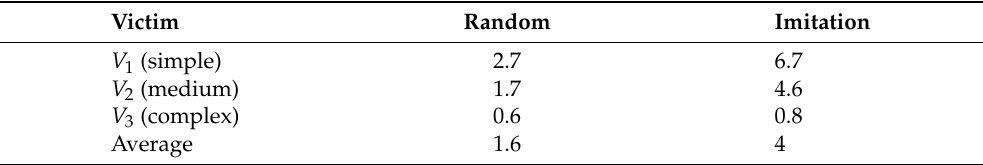
Table 3. Results of random and imitation attacks.